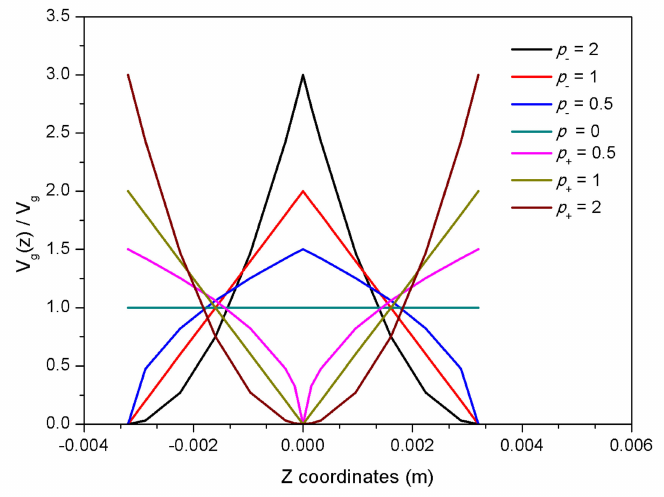
Figure 3. The relative volume fraction of graphite along the Z